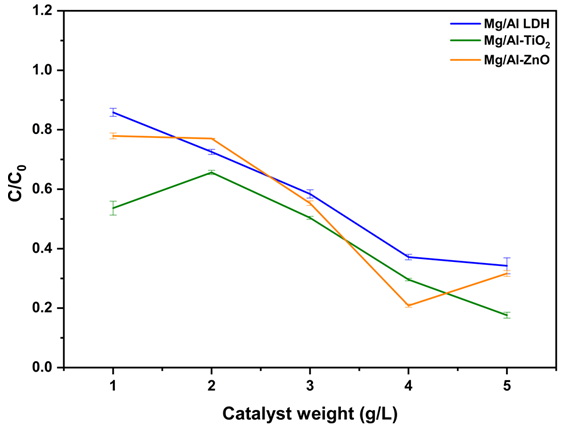
Fig. 4. Effect of catalyst weight on CR photodegradation Variation in radiation times can indicate the optimum photodegradation time so that there is no inefficient excess of time. Figure 5 shows the photodegradation of CR at the Fig. 3. Effect of pH on CR photodegradation optimum pH and weight of each catalyst over time. After contacting the catalyst with 100 mg/L of CR solution in the dark for 60 minutes, 41.5 mg/L, 26.3 mg/L and 47.5 mg/L CR was left as C 0 for Mg/Al LDH. Mg/Al-TiO 2 and Mg/Al-ZnO, respectively. The photodegradation results showed that after Mg/Al LDH was modified to LDH-metal oxide, it could improve the photodegradation performance. Mg/Al LDH, Mg/Al-TiO 2 and Mg/Al-ZnO catalyzed the photodegradation of CR by 65.97%, 73.06 % and 86.86%,